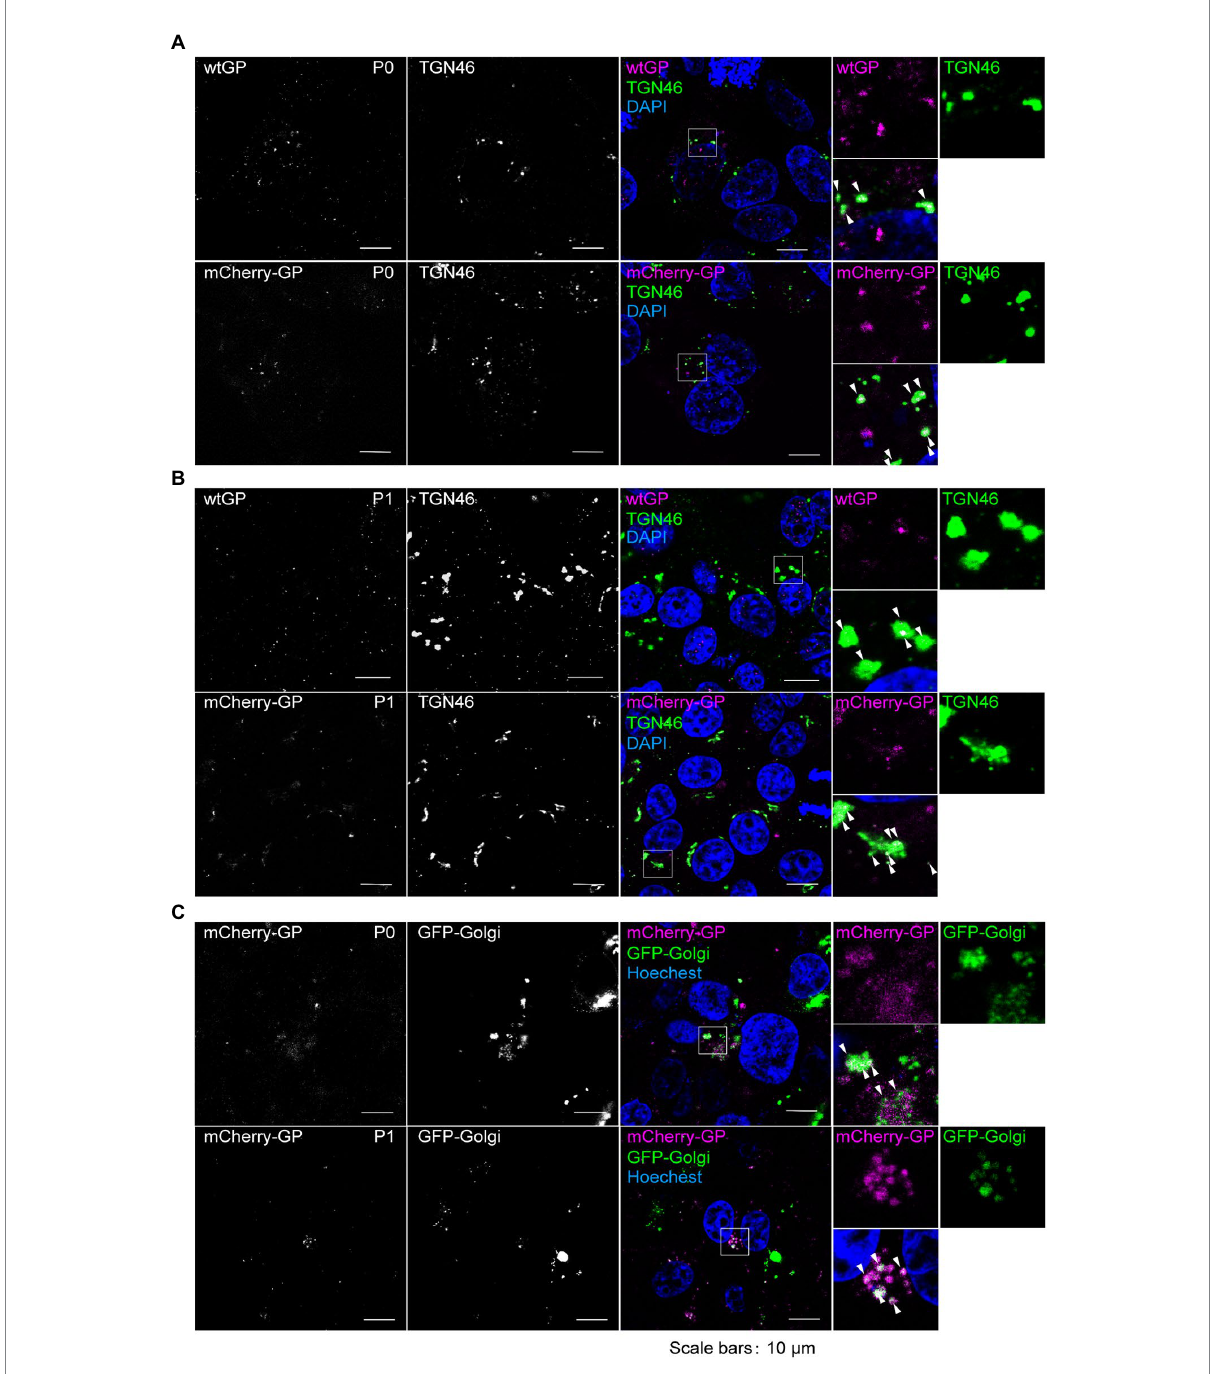
FIGURE 5 Visualization of intracellular traffic of mCherry-GP in the trVLP-infected cells. (A) Distribution of mCherry-GP in HEK293 (P0 cells). HEK293 cells were co-transfected with the plasmid for minigenome and the expression plasmids for T7 and RNP proteins. At 48 hpt, the cells were harvested and intracellular distributions of wtGP (top, magenta in the merged images) or mCherry-GP (bottom, magenta in the merged images) and TGN46 (middle, green in the merged images) were analyzed by immunofluorescence staining with antibodies against GP (for wtGP) or TGN46, respectively. (B) Distribution of mCherry-GP in Vero-E6 (P1 cells). Vero-E6 cells pre-transfected with the expression plasmids for the RNP proteins were incubated with trVLP-wtGP (top) or trVLP-mCherry-GP (bottom). Forty-eight hours after inoculation, the cells were harvested and intracellular distributions of wtGP (top) or mCherry-GP (bottom) and TGN46 (middle) were analyzed as described above. (C) Live-cell imaging of mCherry-GP in P0 and P1 cells. HEK293 (P0 cells, top) or Vero-E6 cells (P1 cells, bottom) were pre-transfected with an expression plasmid for GFP-Golgi. At 48 hpt, distribution of mCherry-GP was analyzed by confocal laser scanning microscopy. Nuclei (blue) were counterstained with DAPI (A,B) or Hoechst 33342 (C) . Insets show the enlarged images of boxed areas. Arrows represent co-localized signals. Scale bars: 10 μ